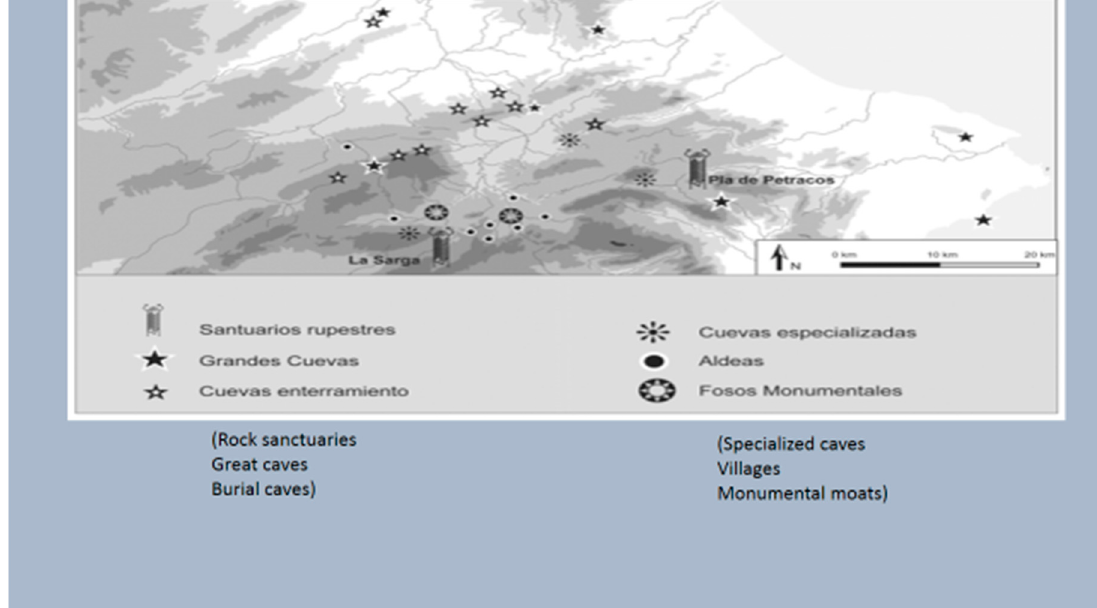
Figure 17. The connection of the macroschematic territory. Source: (Auban et al. 2003, p. 50).